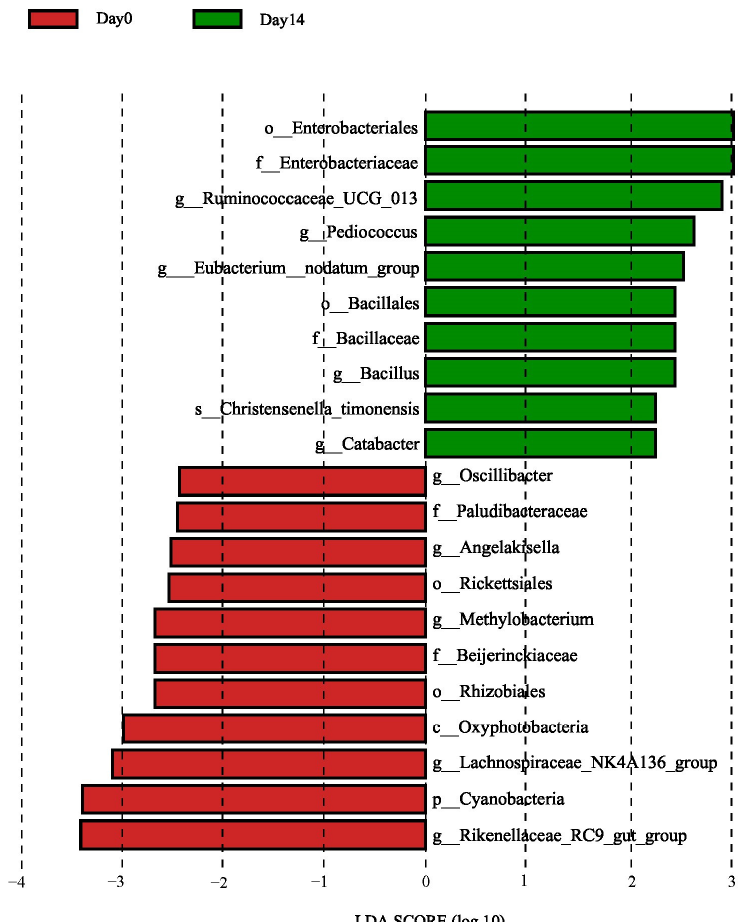
Figure 3. LEfSe showed the significantly different bacterial taxa of which the LDA scores were above 2 between day 0 and day 14 group.